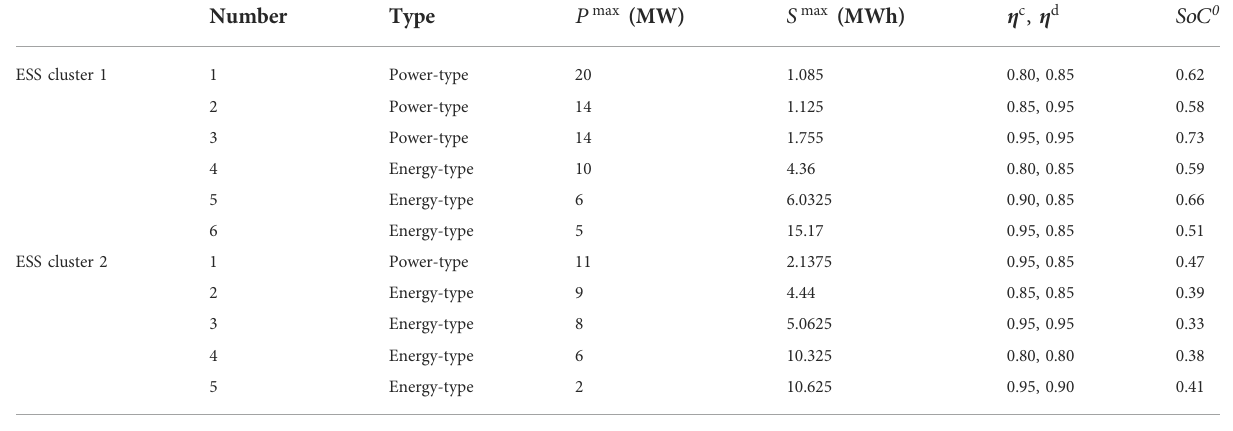
TABLE 2 Parameters of energy storage units.